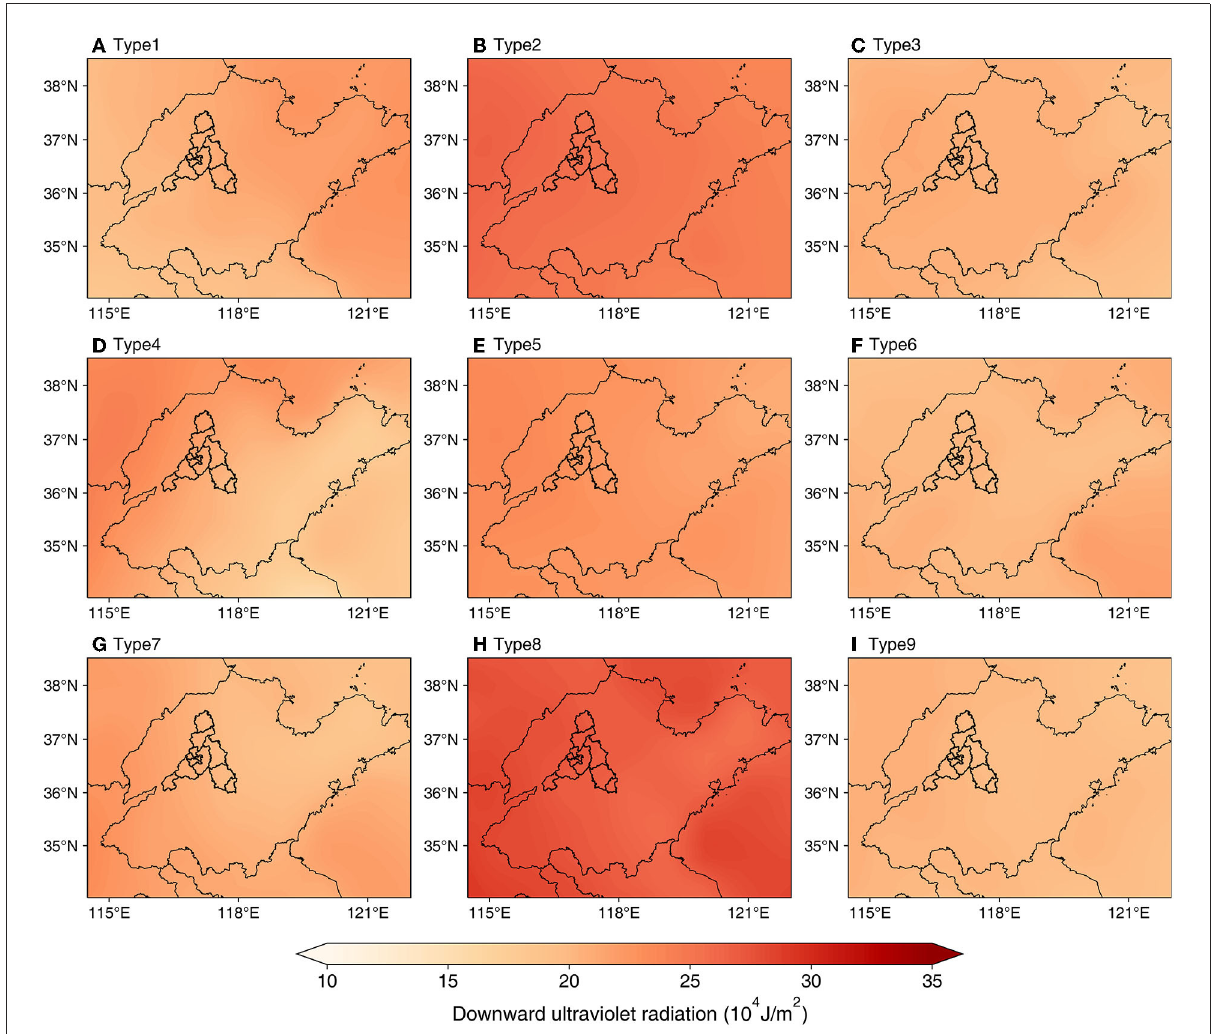
FIGURE7 Downward UV radiation at the surface in 9 synoptic patterns during 2013–2020 in North